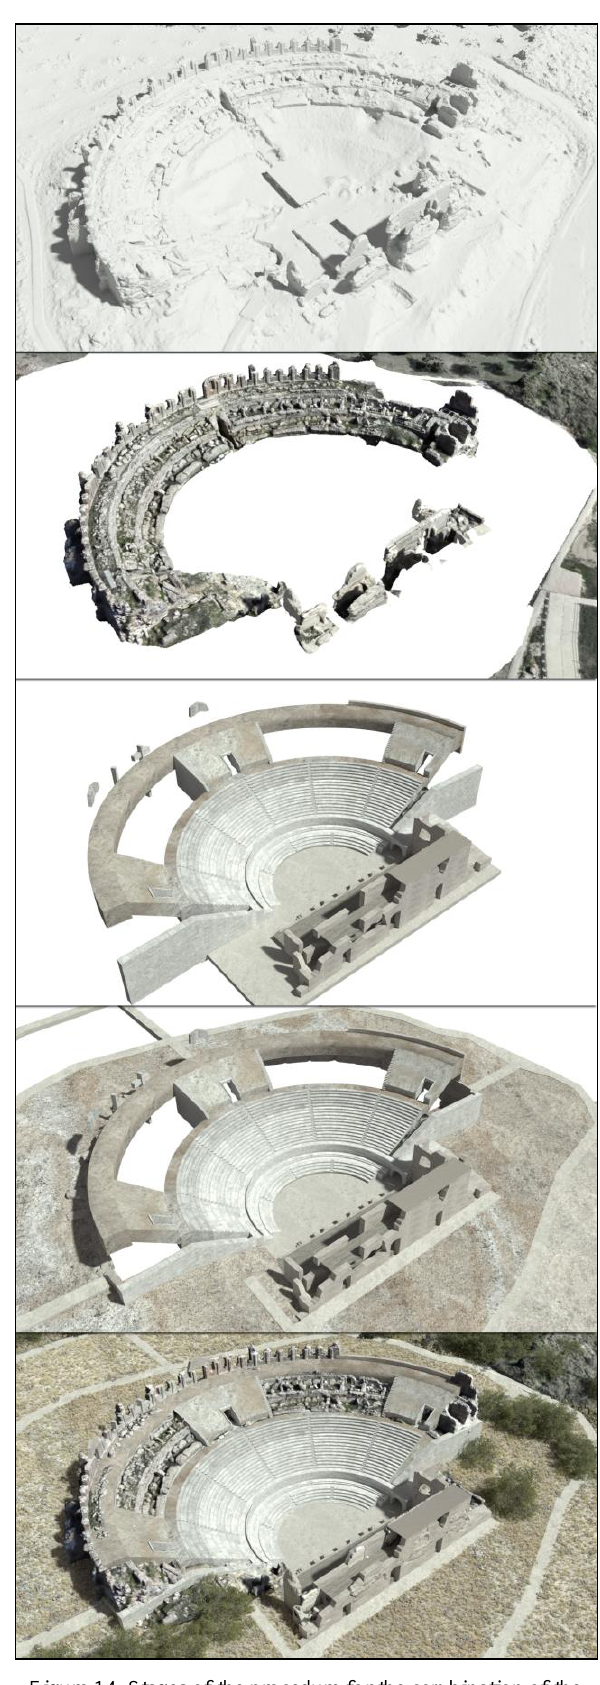
Figure 14. Stages of the procedure for the combination of the original 3D model and the restoration proposal 3D